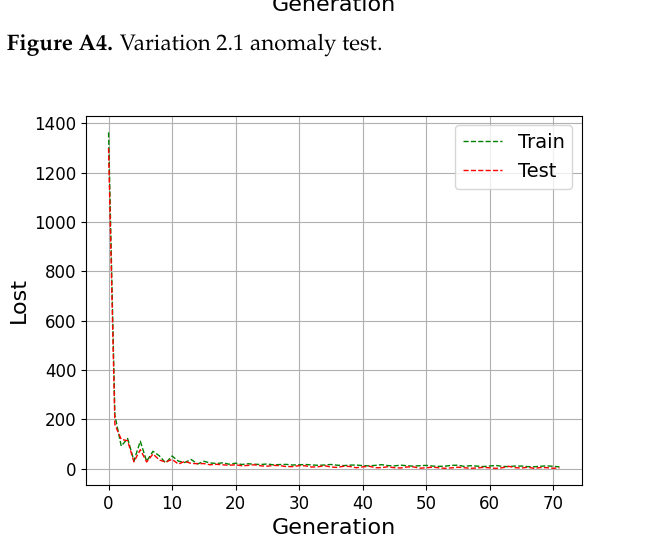
Figure A4. Variation 2.1 anomaly test.